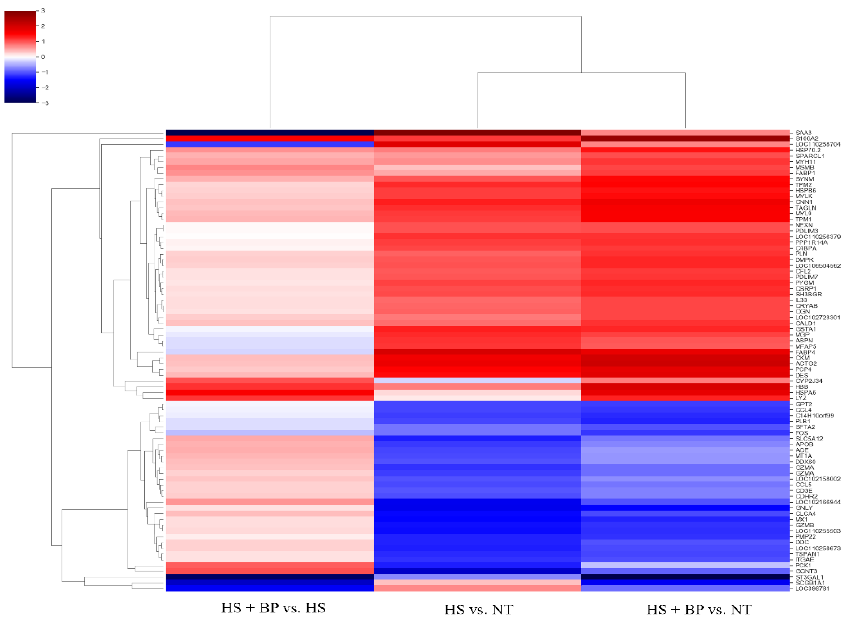
Figure 2. Hierarchical clustering of DEGs in HS vs. NT, HS + BP vs. NT, and HS + BP vs. HS; NT, normal temperature; HS, heat stress; HS + BP, dietary beet pulp under heat stress; Up- and downregulated genes are shown in red and blue color, respectively.